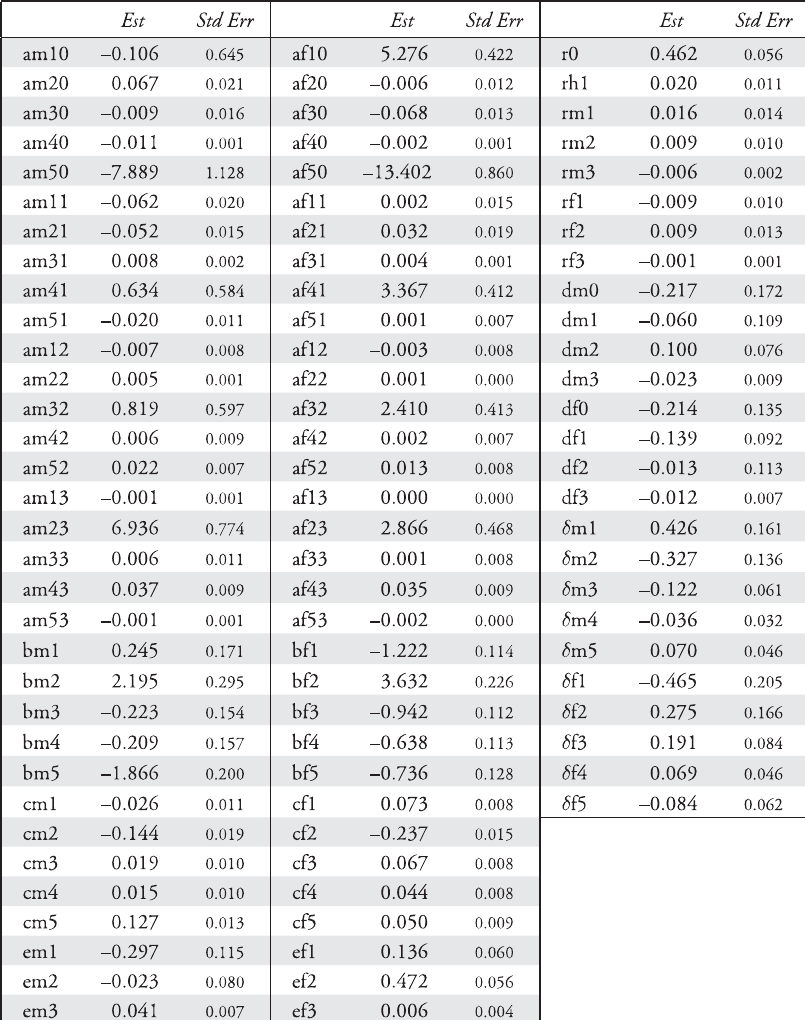
Table 8: Estimates of the 92 Parameters of the Main